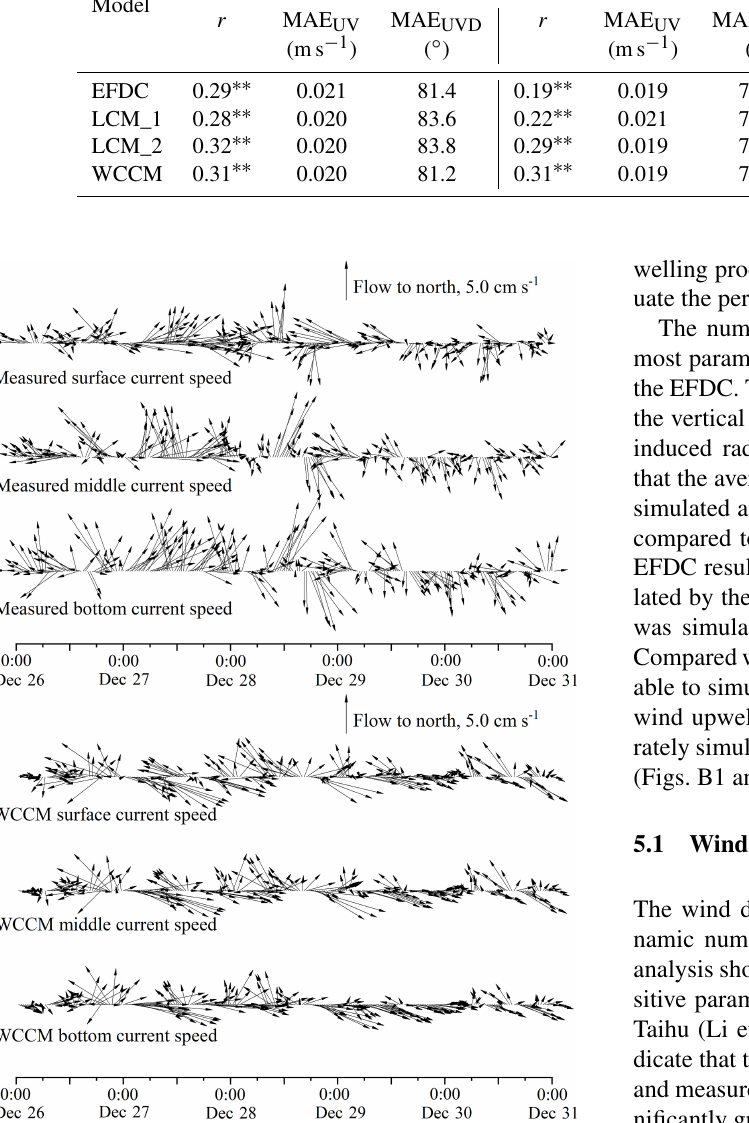
Figure 11. Comparison between the measured and WCCM- simulated surface, middle, and bottom current speeds at the LHWS during the 2018 winter